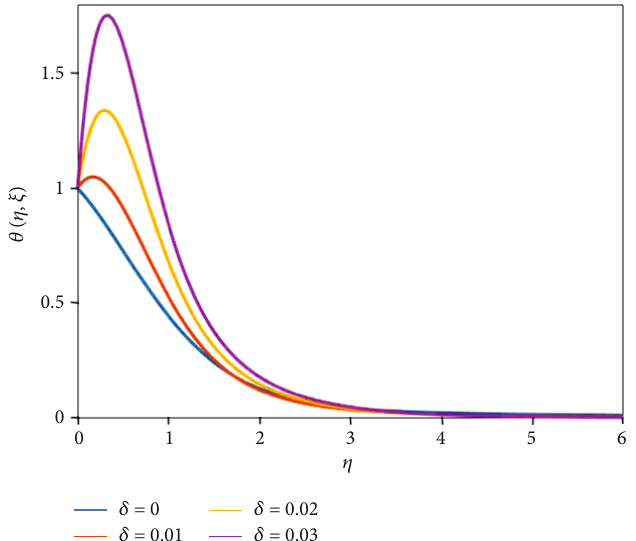
Figure 2: Velocity pro fi le for di ff erent values of δ when λ = 0 : 1, N = 0 : 5, n = 0 : 5, f = 0 : 2, Sc = 0 : 6, and Pr = 1 :